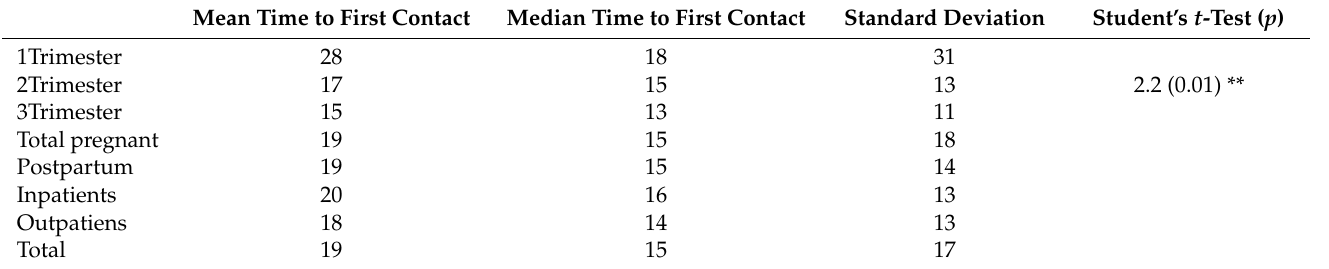
Table 3. Mean time to first contact for pregnant and postpartum patients (days).